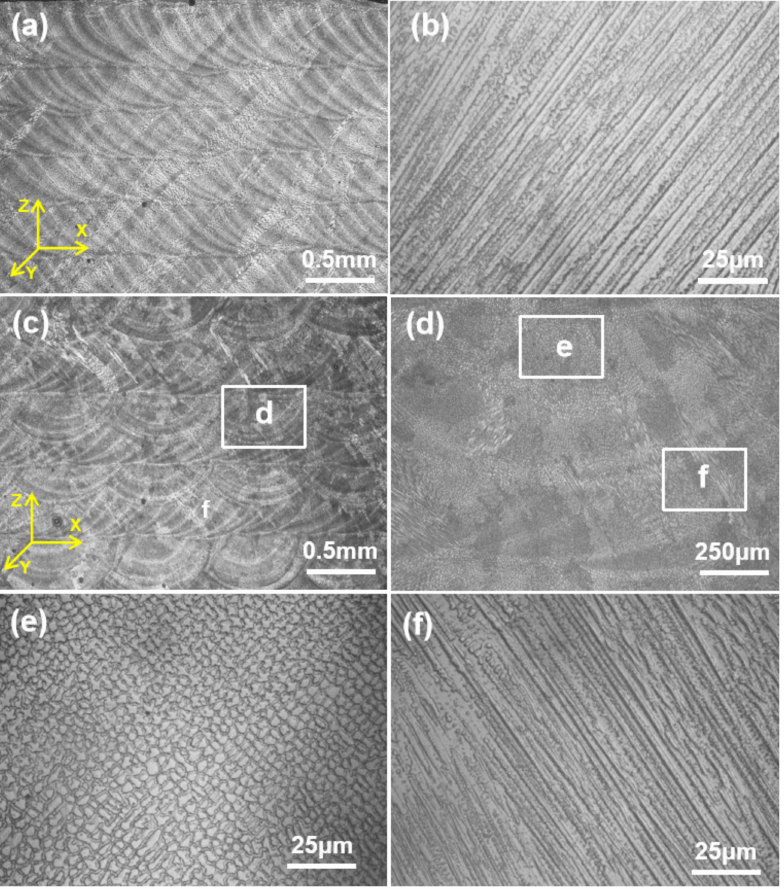
Figure 2. Longitudinal cross-sectional optical micrographs of as-fabricated samples under different scanning strategies: ( a , b ) SDS and ( c – f )